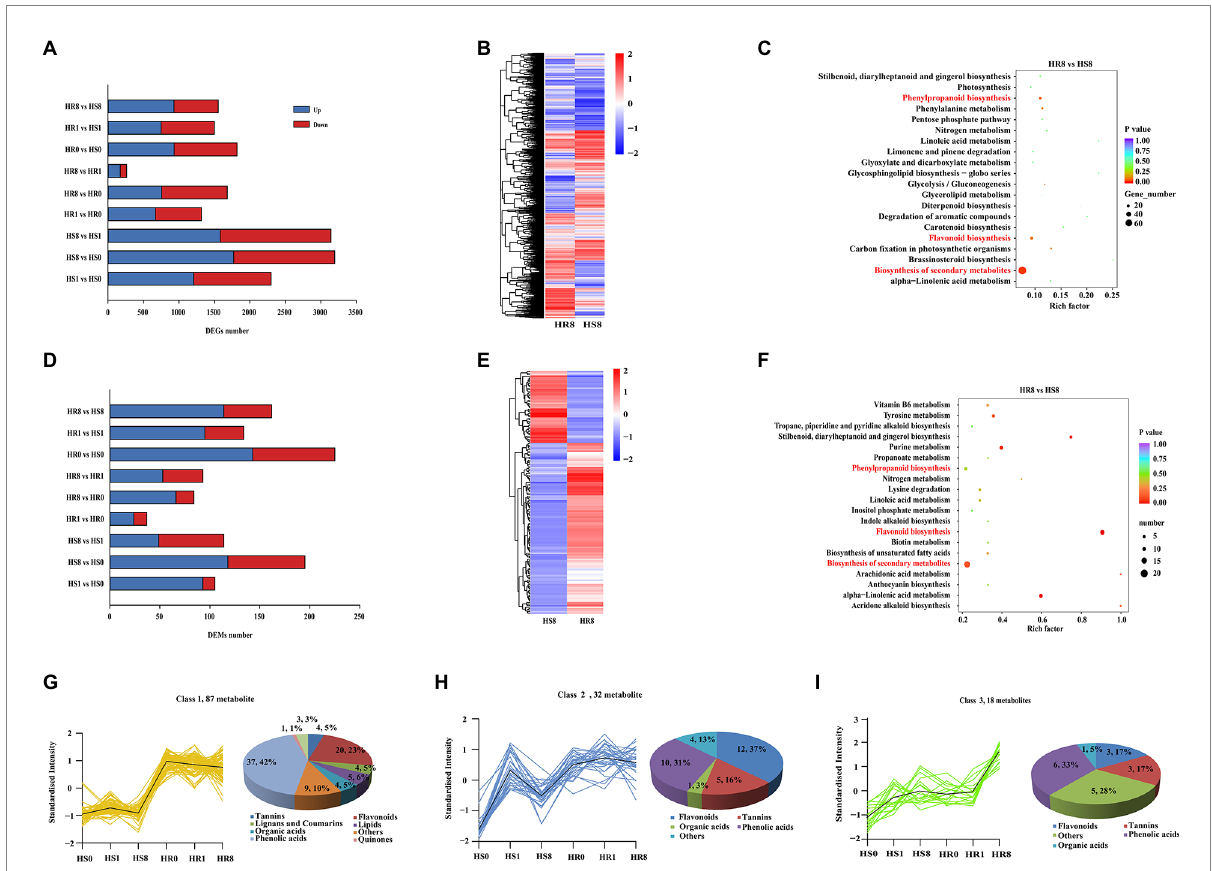
FIGURE 1 Comparative transcriptome and metabolome analysis of HR and HS cassava cultivars under TSSM infestation. (A) The overview of differently expressed genes (DEGs) between HR and HS cultivars at different infestation time points [0 d (HR0 and HS0), 1 d (HR1 and HS1), and 8 d (HR8 and HS8)]. (B) Heatmap cluster analysis of DEGs in the “HR8 vs. HS8” group. (C) The Kyoto Encyclopedia of Genes and Genomes (KEGG) enrichment analysis of DEGs in the “HR8 vs. HS8” group, the pathways highlighted with red font indicate either abundant genes or high rich factors. (D) The overview of differently expressed metabolites (DEMs) between HR and HS cultivars at different infestation time points (0, 1, and 8 d). (E) Heatmap cluster analysis of DEMs in the “HR8 vs. HS8” group. (F) The KEGG enrichment analysis of DEMs in the “HR8 vs. HS8” group. The